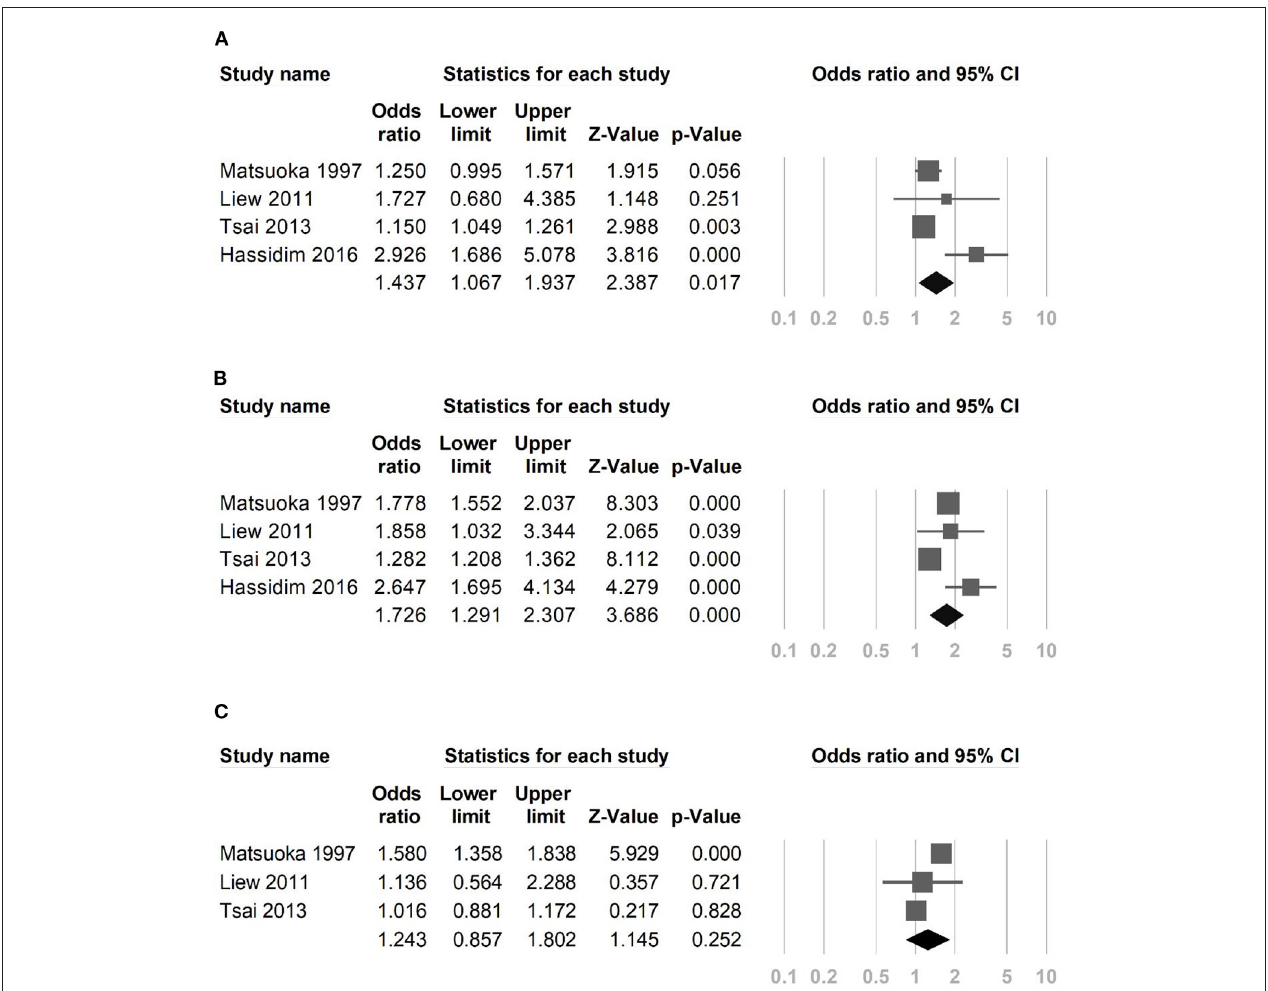
FIGURE 2 | Forest plot in the meta-analysis of (A) asthma among patients with Kawasaki disease, (B) allergic rhinitis among patients with Kawasaki disease, (C) atopic dermatitis among patients with Kawasaki disease.